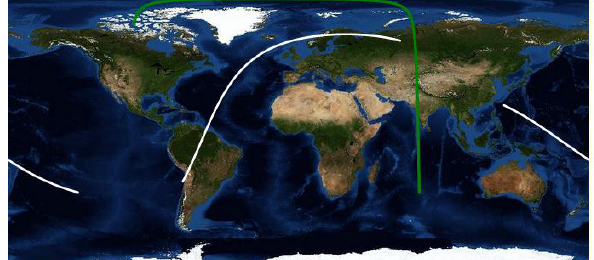
Figure 4. Examples shortest paths in the map section of the visualizer.